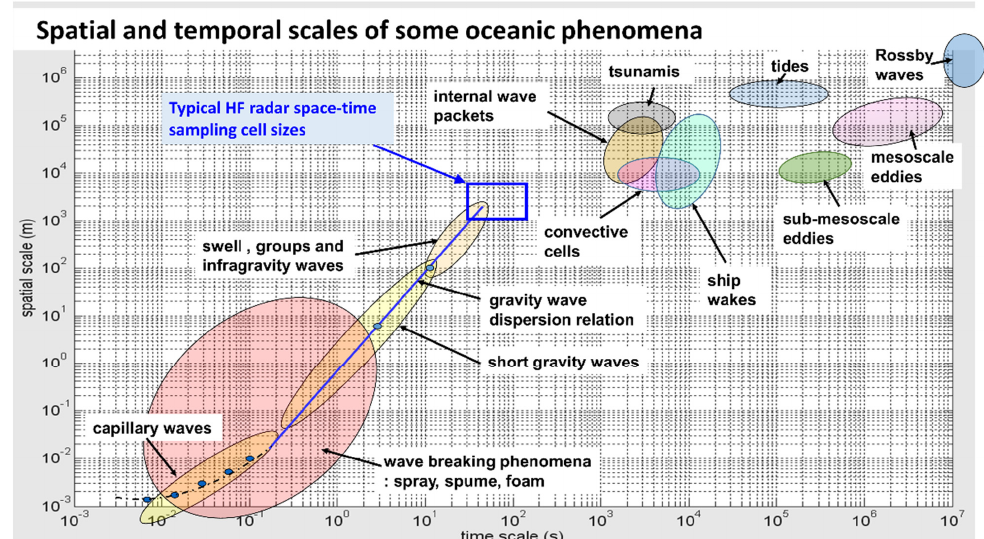
Figure 1. Spatial and temporal scales of some oceanic phenomena. The effective resolution or sam- pling cell dimension when a skywave radar is used for remote sensing usually falls within the blue rectangle.